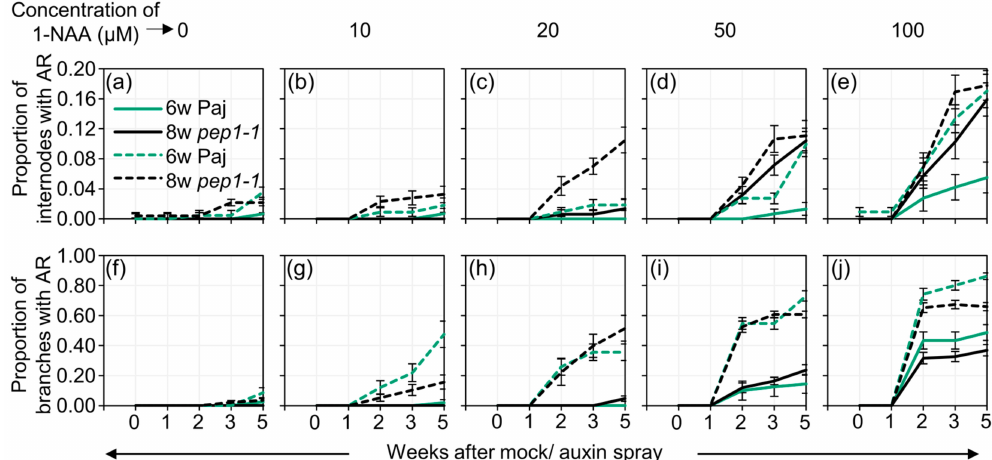
Figure 3. Auxin spray induces adventitious roots in a dosage- and age- dependent manner. Proportion of ( a – e ) internodes and ( f – j ) axillary branches with adventitious roots after the application of 0 µ M, 10 µ M, 20 µ M, 50 µ M and 100 µ M 1-NAA relative to before spraying in six- (6w) and eight-week-old (8w) Paj and pep1-1 plants. Ten plants were scored for each treatment. Plants were scored before spraying and one, two, three and five weeks after spraying. The data and statistical analyses are tabulated in Tables